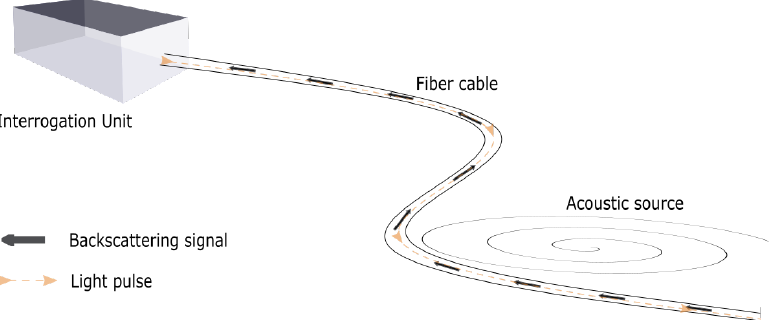
Figure 1. The Distributed Acoustic Sensor carries light pulse travelling inside the fibre cable that are backscattered to the Interrogation Unit that recovers the acoustic signal profile along the